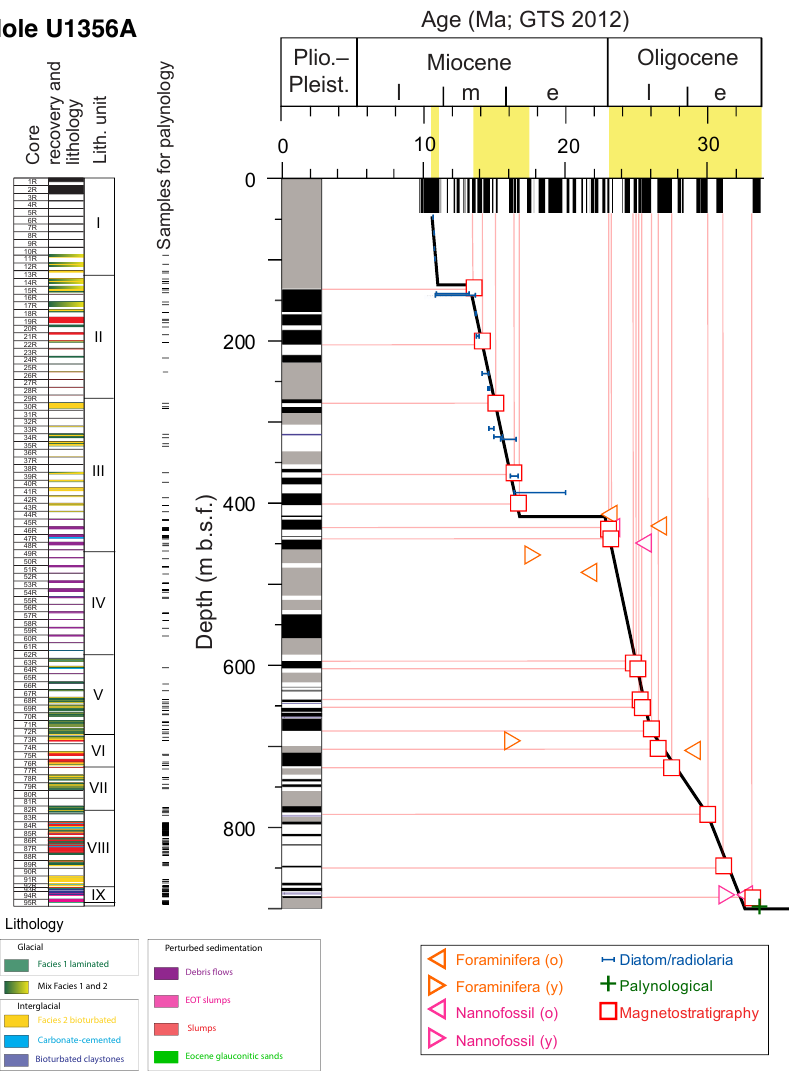
Figure 2. Age model for the Oligocene–Miocene interval of Hole U1356A. Core recovery, lithostratigraphic facies after Salabarnada et al. (2018; see also Sangiorgi et al., 2018) and lithostratigraphic units (Escutia et al., 2011). Samples taken for palynology and age–depth plot (tie points were derived from Tauxe et al., 2012, which has been recalibrated to the GTS2012 timescale of Gradstein et al., 2012, and modified based on Crampton et al., 2016). Grey intervals in paleomagnetic data reflect unknown paleomagnetic orientation, either due to absence of core recovery or poor signal. (o): old end; (y): young end. Figure modified from Bijl et al.